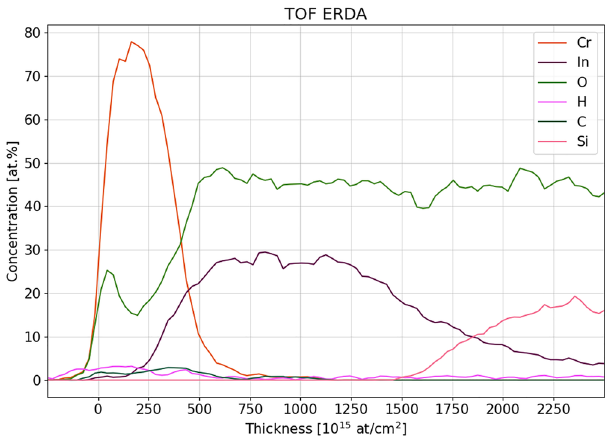
Figure 1. TOF ERDA depth profile of dual-layer Cr-ITO sample on soda-lime glass.